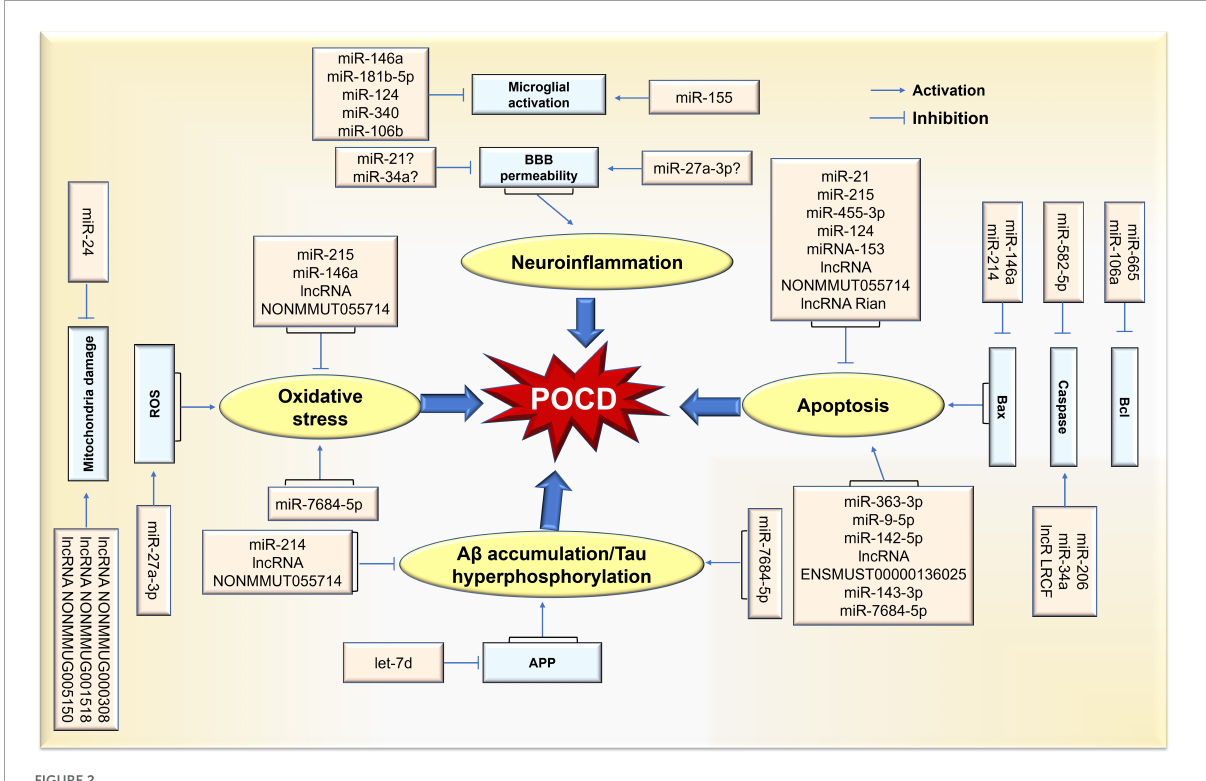
FIGURE2 Schematic representation of ncRNA-mediated pathological process in POCD. Differential expression of ncRNAs caused by surgical/anesthesia results in various functional changes in brain via coordination of network(s) where key targets are upregulated or downregulated. Thus, POCD-associated pathological changes are evident in neuroinflammation, neuronal apoptosis, and oxidative stress rates, as well as A β accumulation/tau